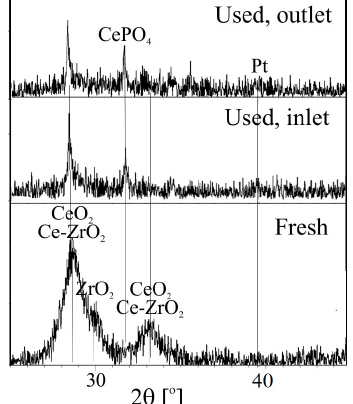
Figure 7. XRD patterns of the fresh and used diesel oxidation catalysts.